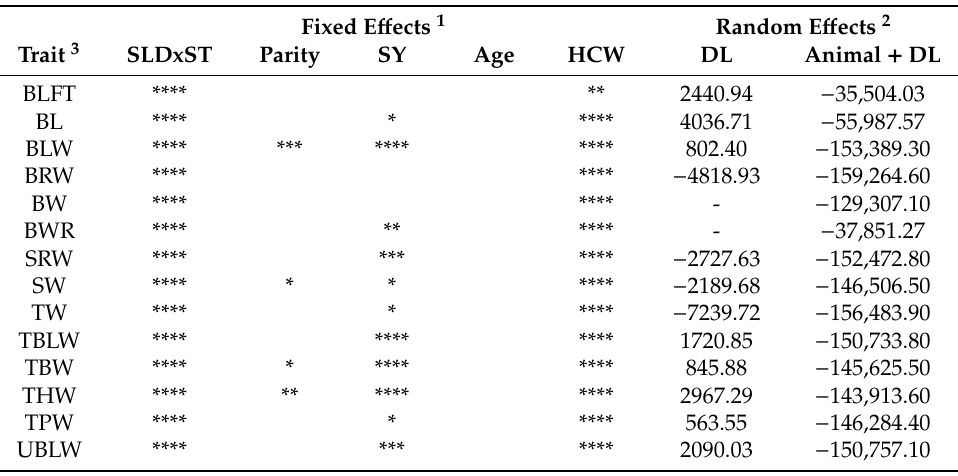
Table 5. Significance of covariate and categorical fixed e ff ects tested for novel carcass traits; and the di ff erent AIC values obtained among the models with and without the random e ff ect of dam-litter